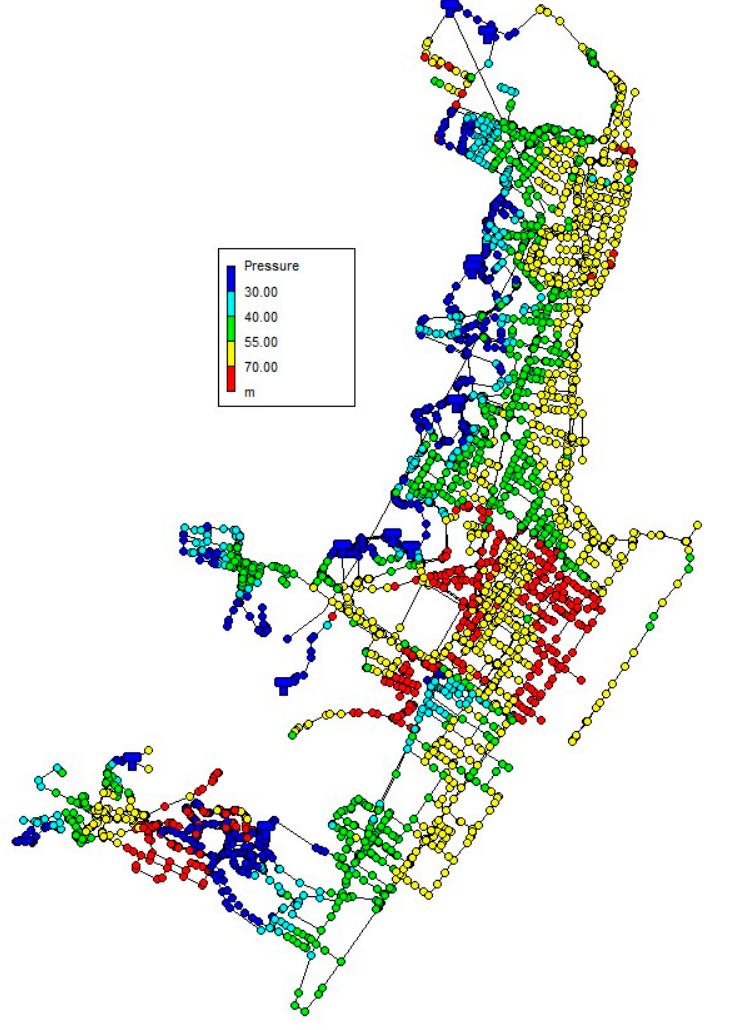
Figure 4. NPR for Messina WDN in Scenario 1 (without partitioning).